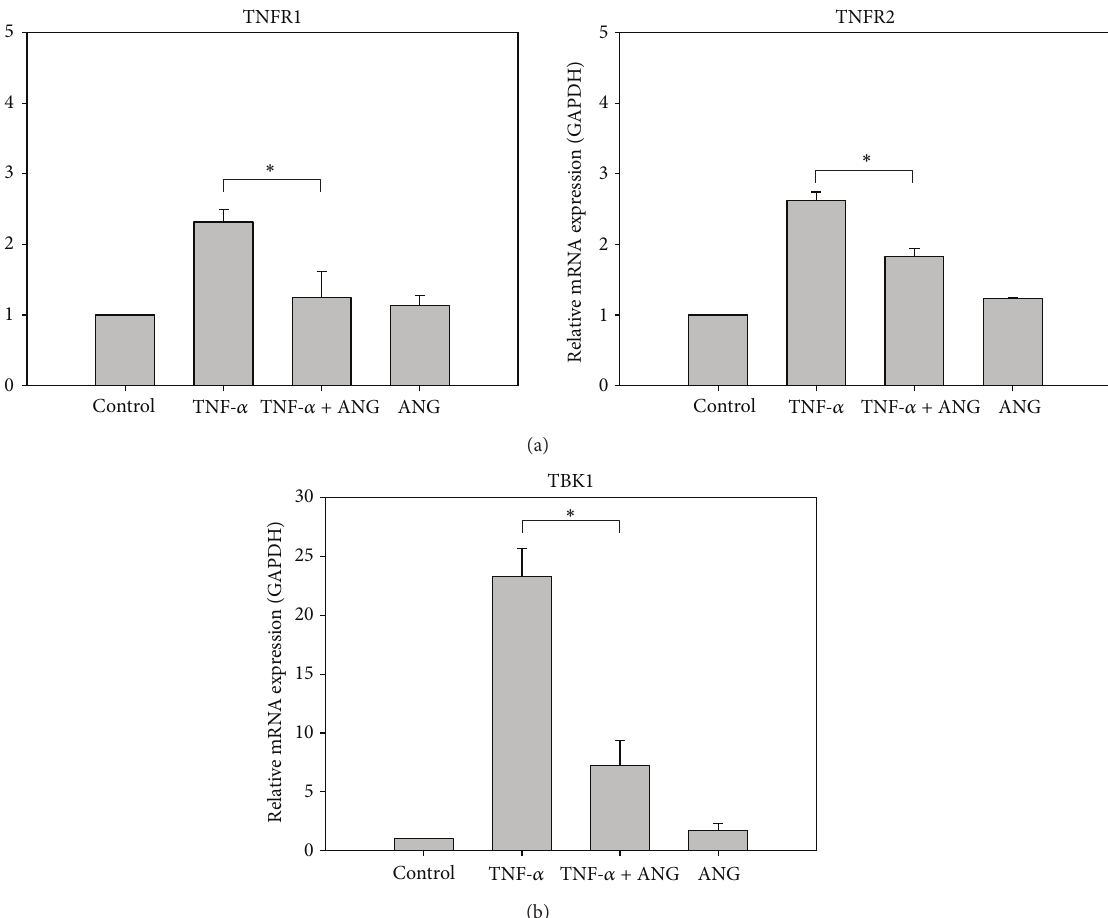
Figure 3: Real-time PCR analysis of TNFR1 and 2 and TBK1 in HCFs. (a) The relative level of TNFR1 and 2 mRNA was diminished by ANG treatment.(b)TherelativelevelofTBK1mRNAwasdiminishedbyANGtreatment.Theexperimentswereperformedintriplicate( ∗ 𝑃 < 0.05